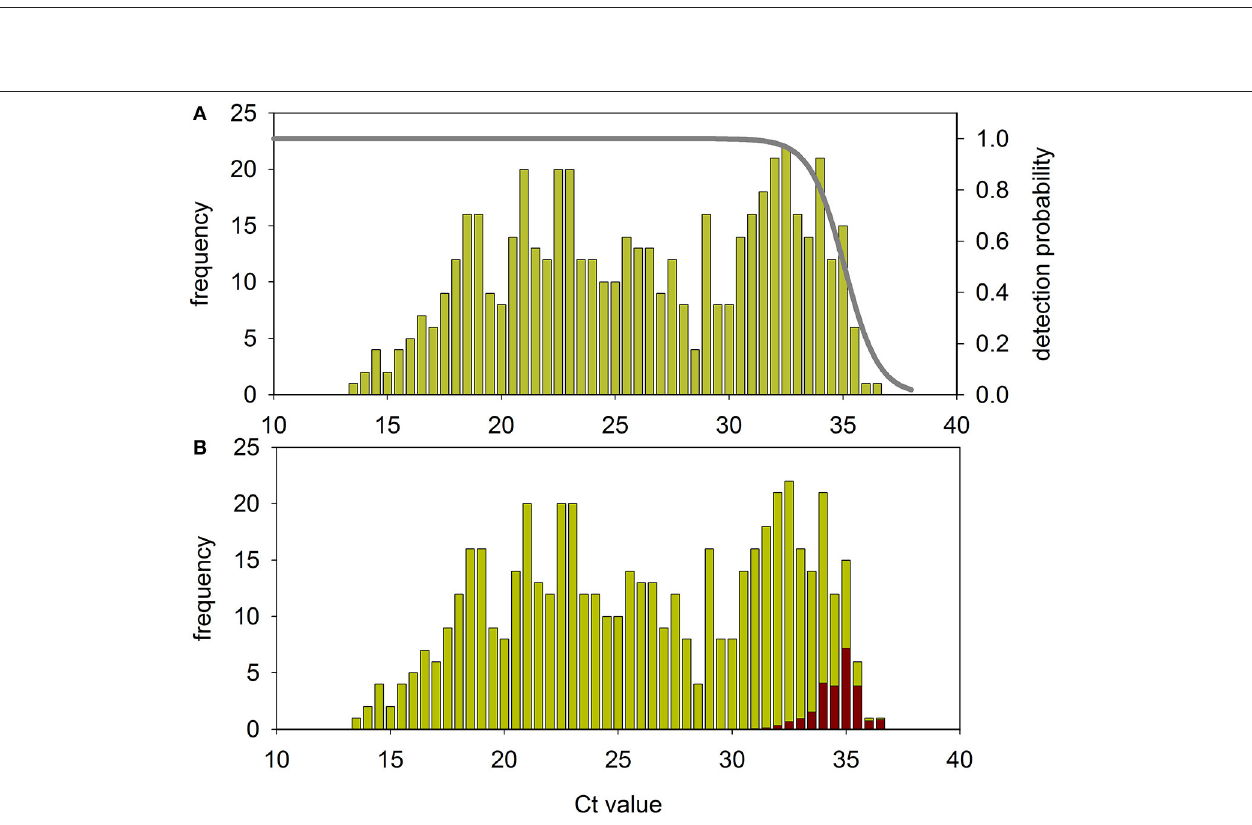
FIGURE 4 | Robustness of the pool method. (A) Histogram of the 526 initial diagnostic samples and probability of their individual detection in a 20 samples pool in experiments performed as depicted in Figures 2 , 3 . (B) The same histogram indicating the fraction of samples that will be not detected in a 20 samples pool (red